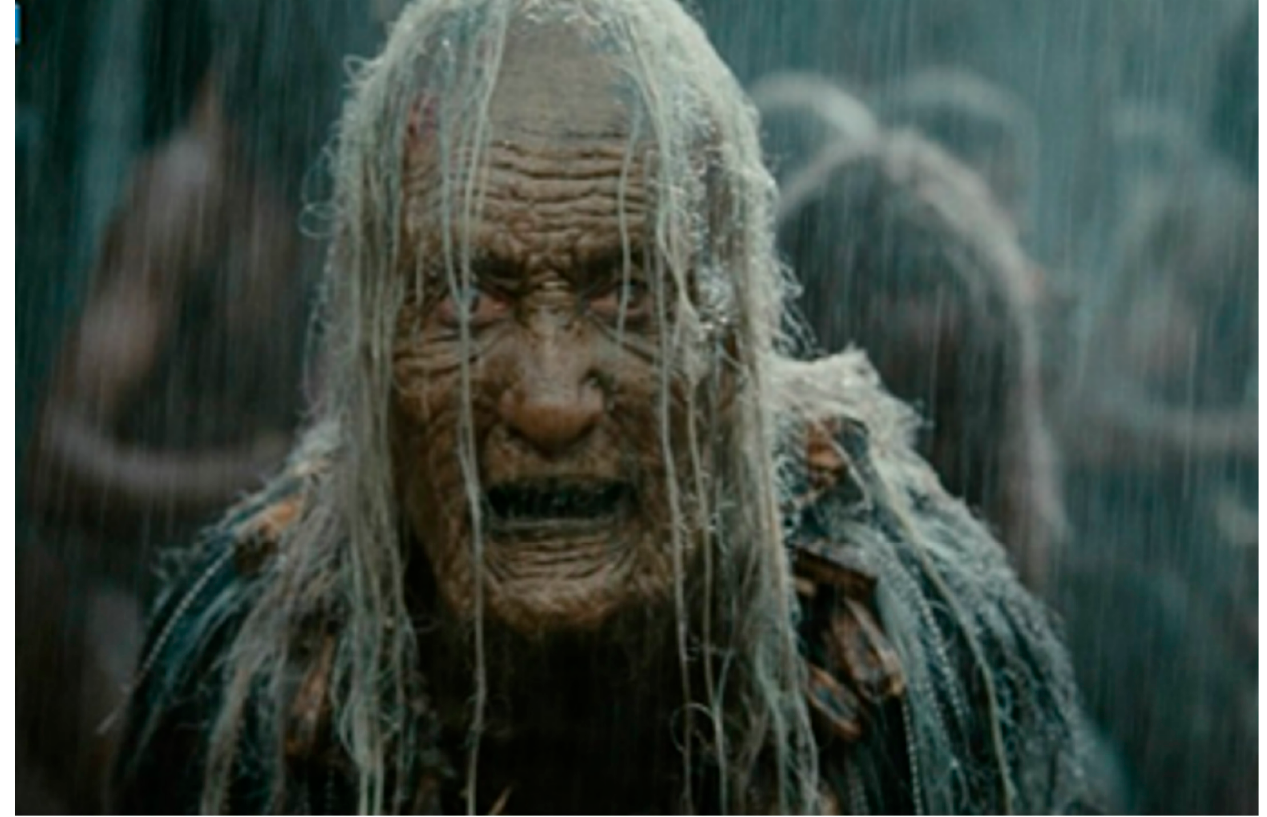
Figure 15. An old witch guides the tribe (2005). https://www.google.es/imgres?imgurl=https://pm1.narvii.com/6860/5366dbdce98d1a1a8fb2cff189afad7a3e00227fr1-512-287v2_hq.jpg&imgrefurl=https://aminoapps.com/c/horror/page/blog/peter-jacksons-king-kong-review/WJdF_XuL825Brg35dZPzr7ojPqqBgjE&h=287&w=512&tbnid=WZ4Uc2NMO7gUGM&tbnh=168&tbnw=300&usg=AI4_-kQ_hO7zVPk4Jw7LCSB9Zh7MDtk-kQ&vet=1&docid=qb-A9OSXyKEEfM&itg=1&hl=es (accessed on 1 January 2021).